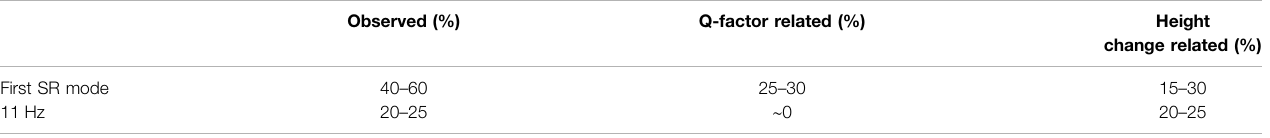
TABLE 4 | Observed SR intensity variations at the VRN station in the H EW fi eld component and the predicted contributions of global Q-factor- and local ionospheric height